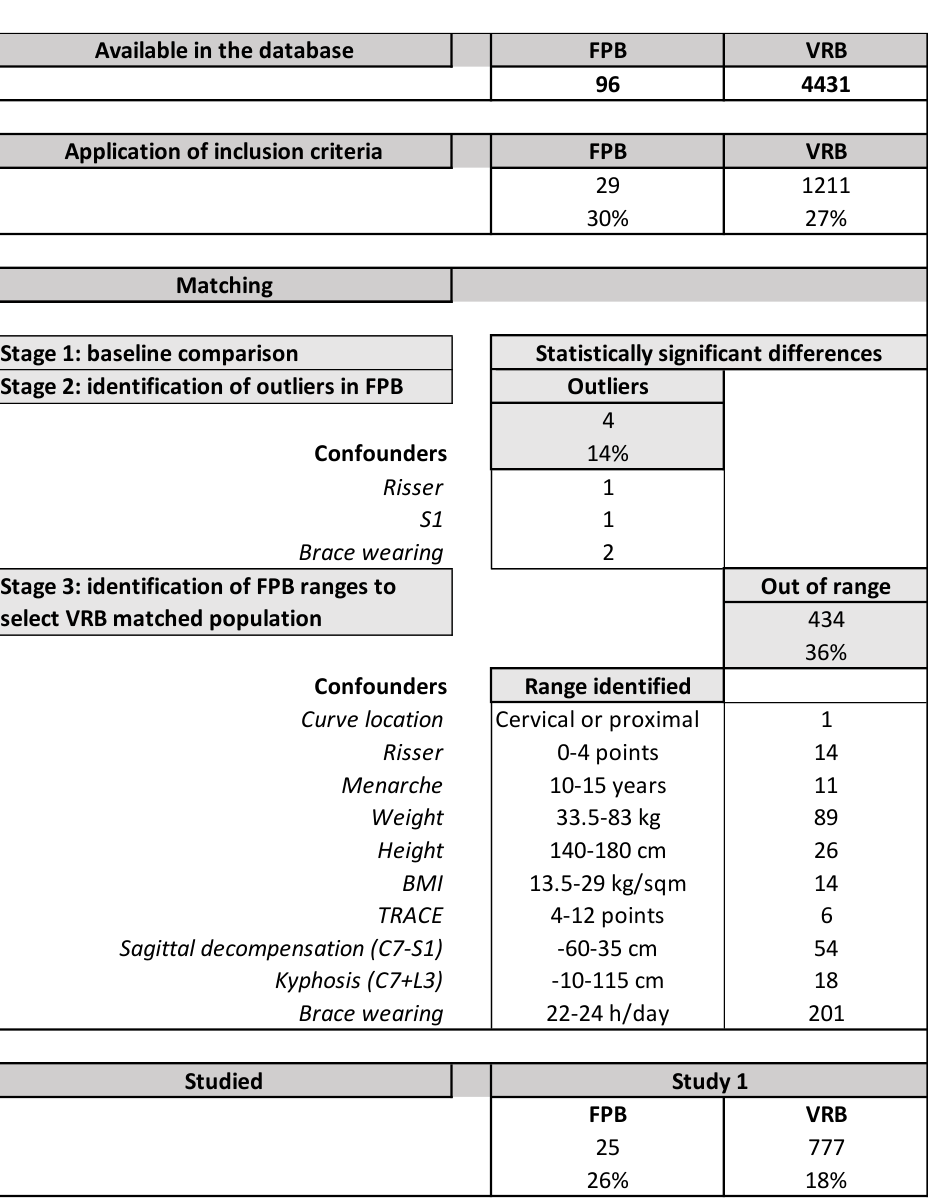
Figure 2. Flow chart of population selection from the clinical data charts.